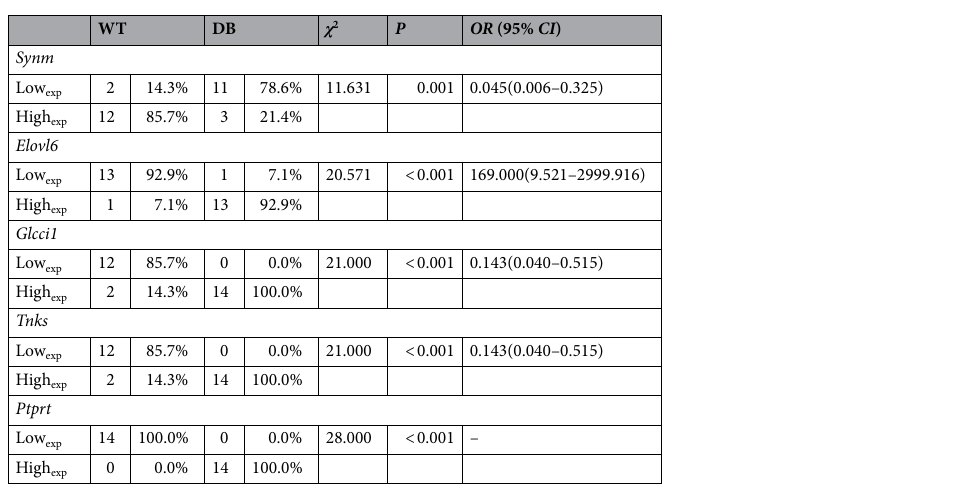
Table 1. Results of the logistic regression analysis of 5 marker